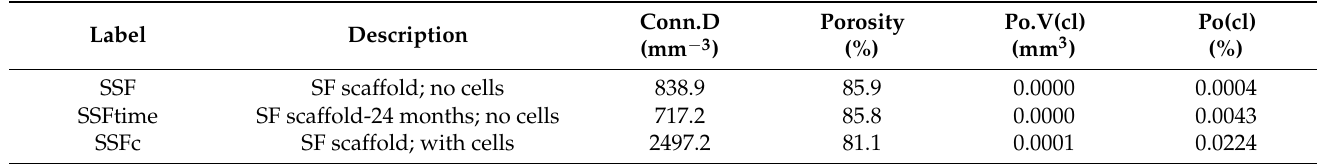
Table 2. 3D Micro-CT analysis, for the selected volume ROI: connectivity density and porosity parameters.